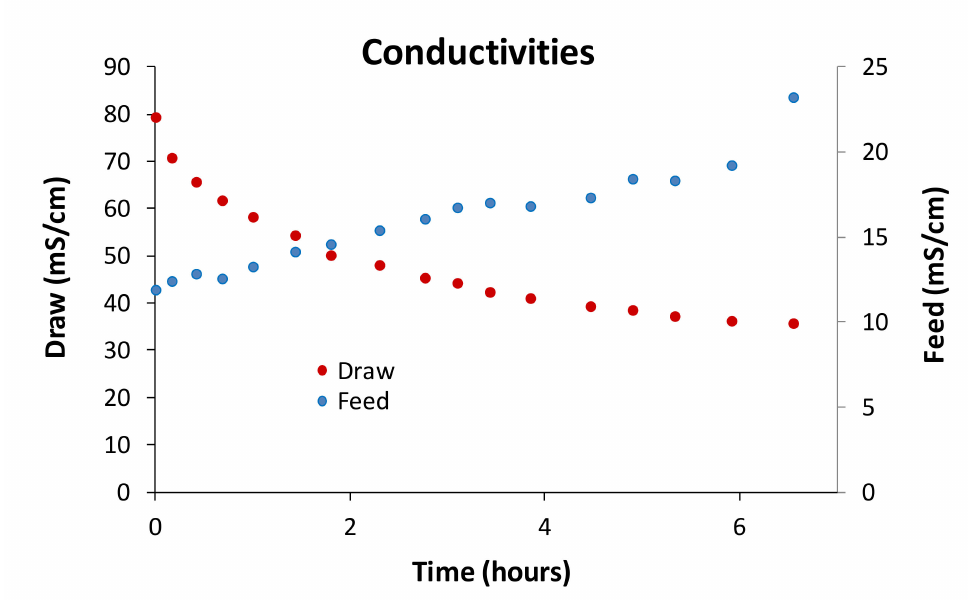
Figure 6. Conductivity of feed and draw solutions versus time in the forward osmosis